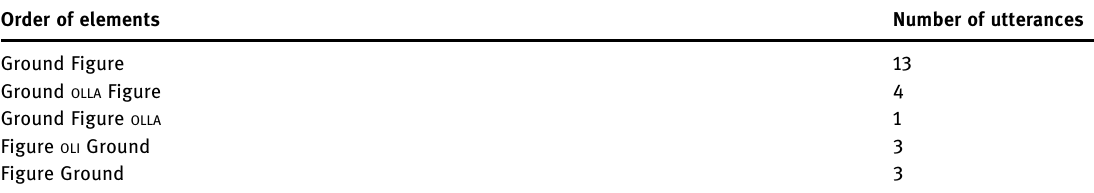
Table 3: A summary of the order of Figure and Ground when Figure is known ( room setting 3 )